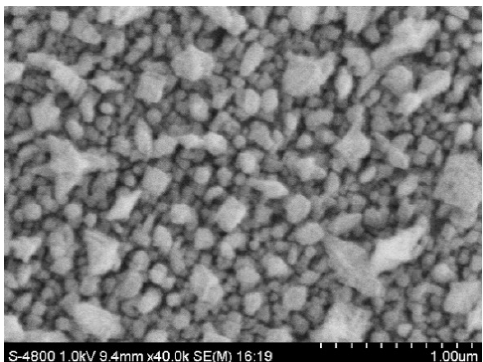
Figure 4. Surface morphology of the ultramicro electrode modified with gold nanoparticles.